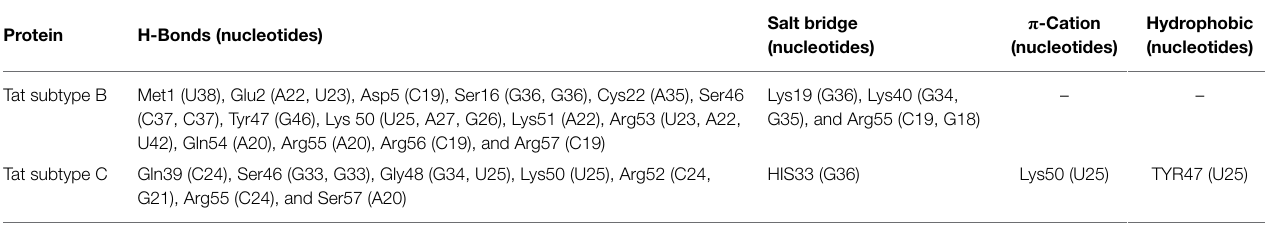
TABLE 2 | The number and type of interactions for both Tat subtype B and C bound to TAR. Protein H-Bonds (nucleotides)